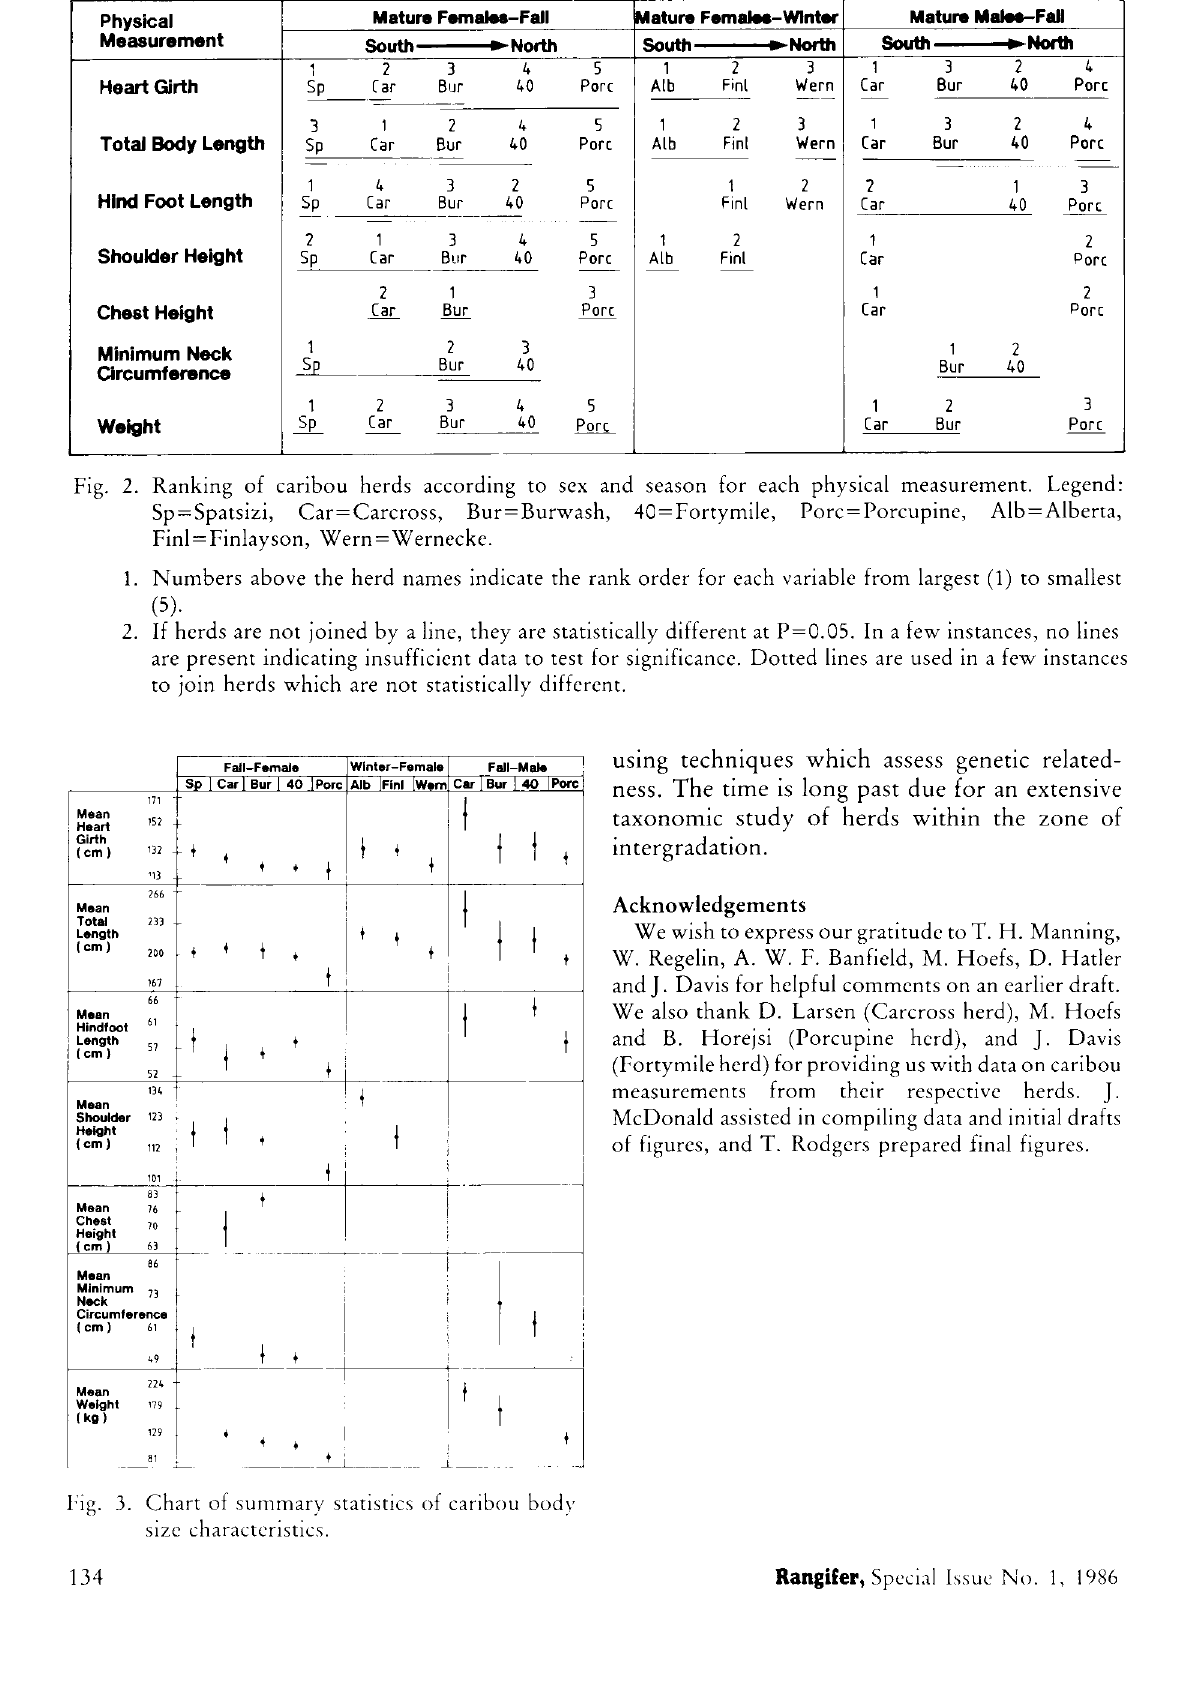
Fig. 3. Chart of summary statistics of caribou body size